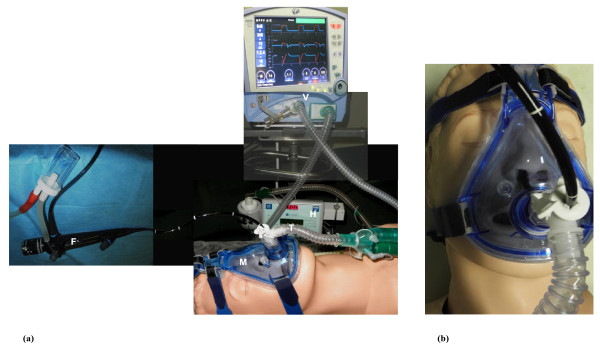
Fiberoptic bronchoscopy. (a) The fiberoptic bronchoscopy (FBO)-noninvasive positive pressure ventilation (NPPV) procedure. (b) The trans-nasally introduction of the bronchoscope. F = fiberoptic bronchoscope; H = heated humidifier; M = mask; T = T-adapter; V = ventilator.